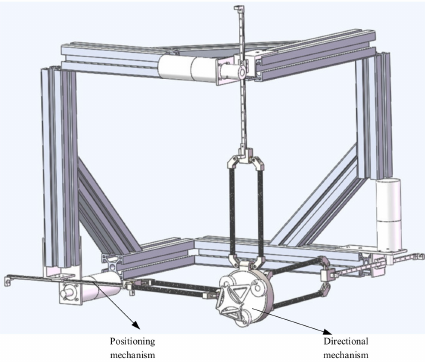
Figure 5. Overall assembly diagram of the haptic device.